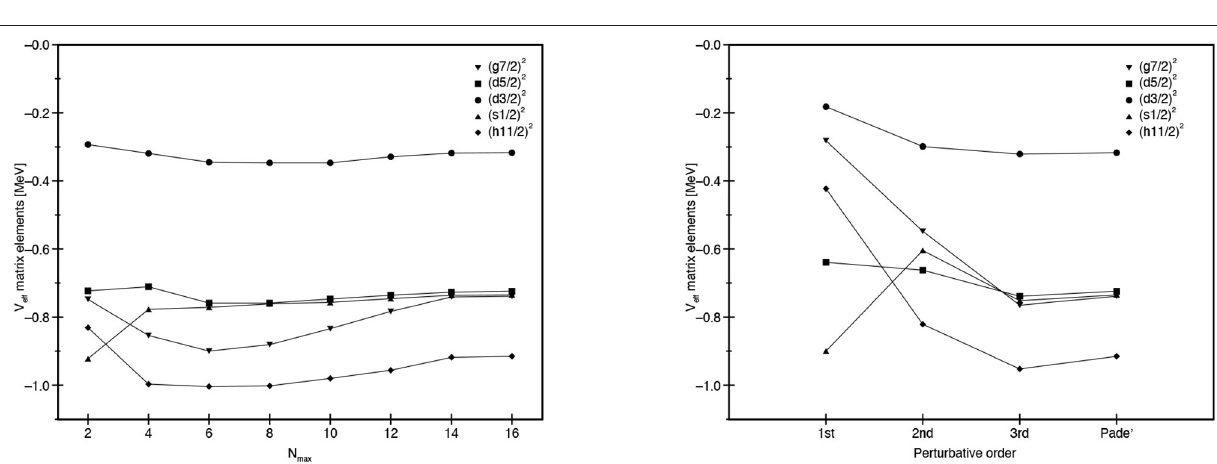
FIGURE 16 | Neutron-neutron diagonal J π = 0 + TBMEs as a function of N max (left) and of the perturbative order (right). Reproduced from reference [122] under the Creative Commons CC BY